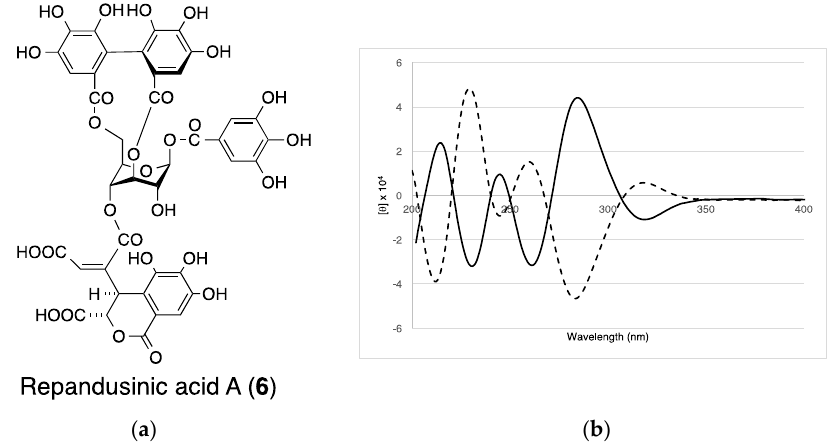
Figure 3. Determination of the stereochemistry of davicratinic acid A ( 5 ). ( a ) Structure of repandusinic acid A ( 6 ); ( b ) Comparison of the ECD spectra between 5 (solid line) and 6 (dashed line).